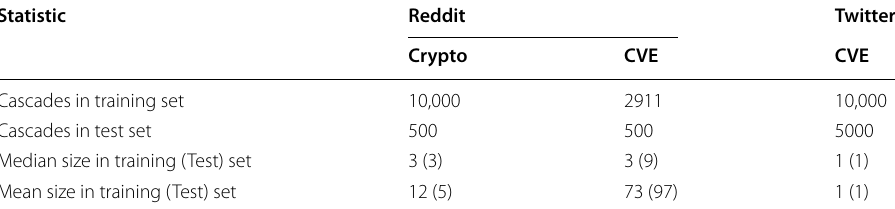
Table 4 Statistics about the three cascade datasets